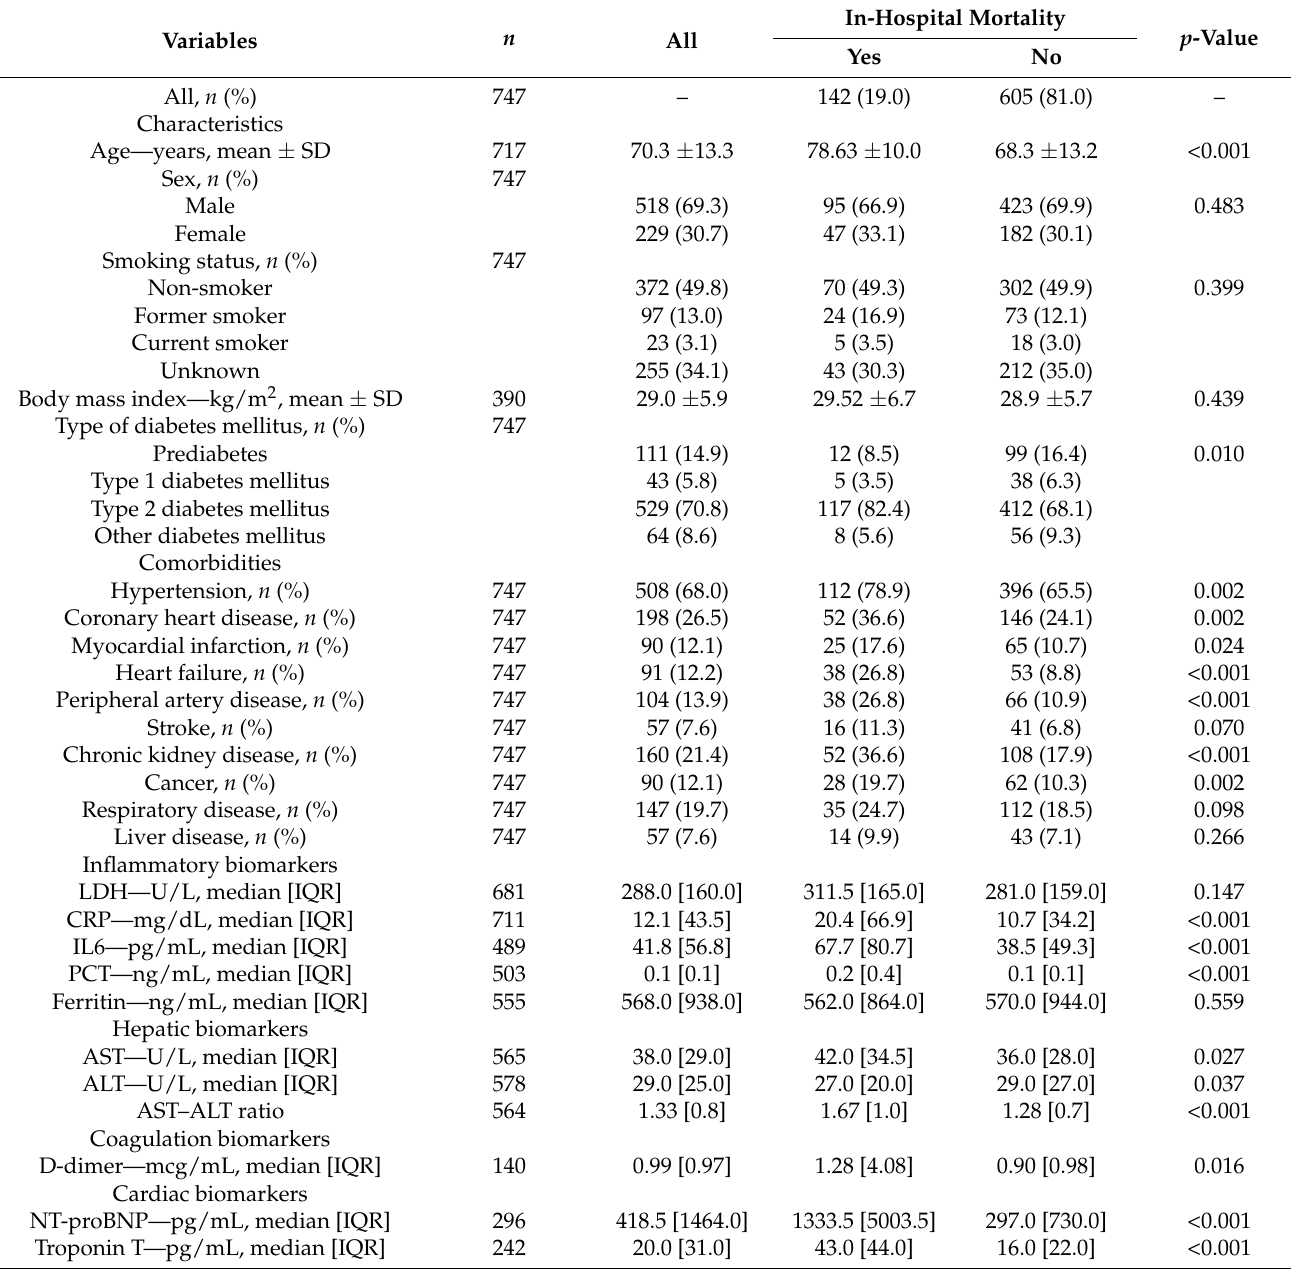
Table 1. Comparison of characteristics, comorbidities, and biomarkers with in-hospital mortality in patients with prediabetes and diabetes mellitus hospitalized with